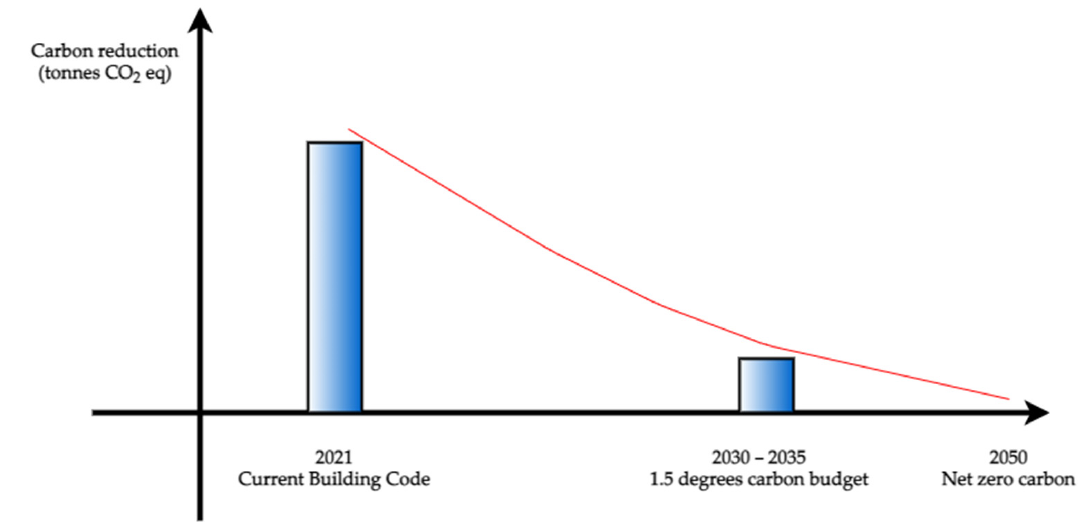
Figure 1. A proposed roadmap towards zero carbon buildings for the New Zealand construction industry (Author’s source).